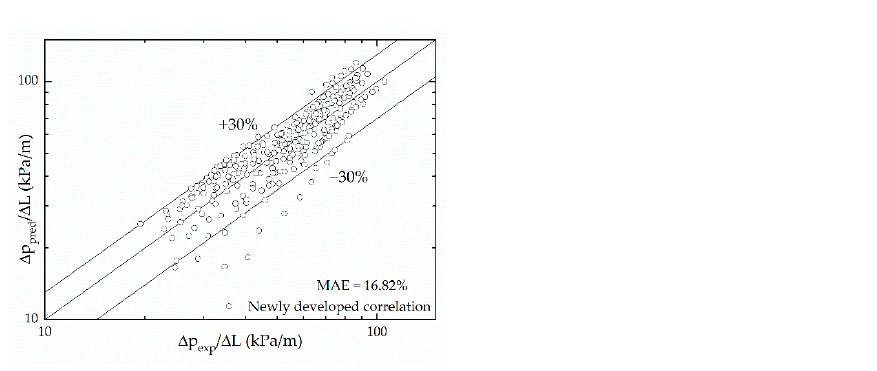
Figure 11. Comparison of pressure frictional pressure drop data with predictions of the separated flow correlation with the new C.